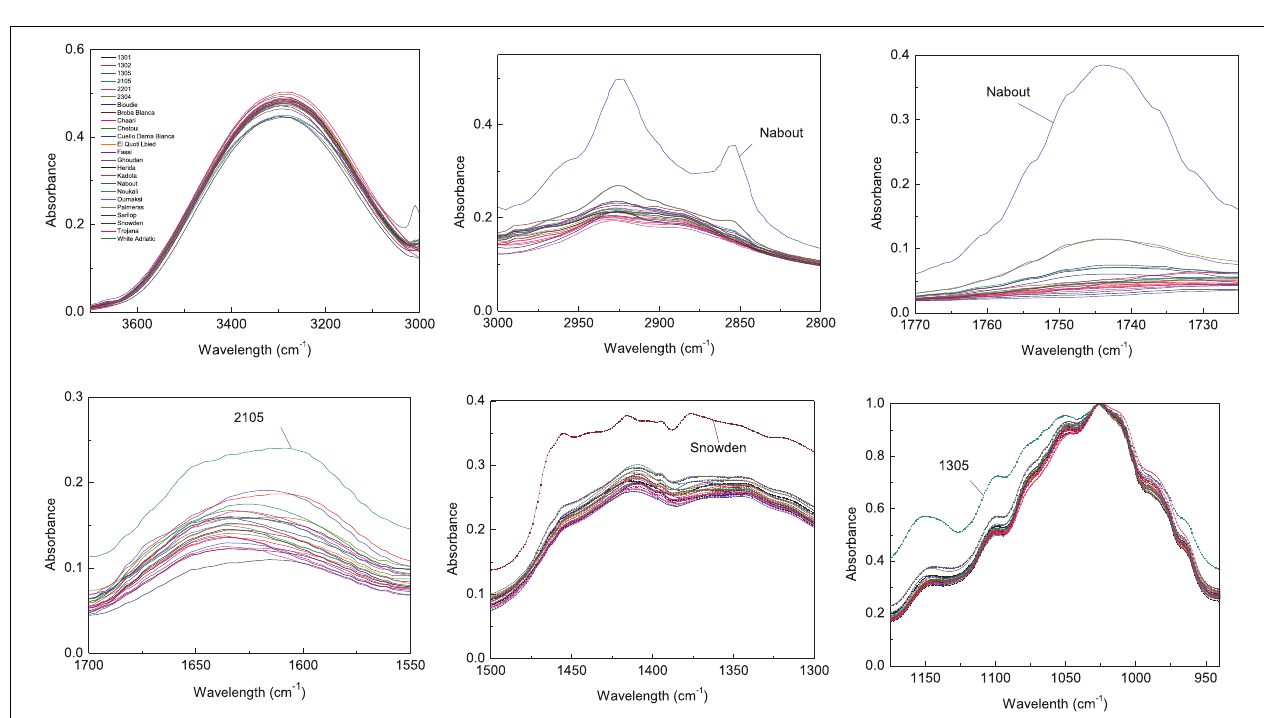
FIGURE 2 | Integrated ATR spectra of the major wavenumbers in pulp samples. Each sample IR represent the mean of 3 spectra, which correspond each to the accumulation of 128 scans using a nominal resolution of 4 cm − 1 .